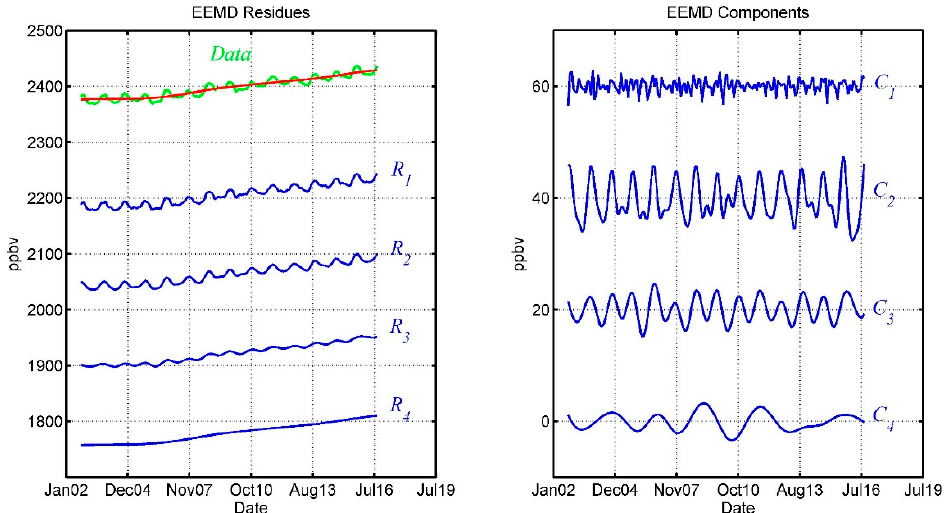
Figure 2. Ensemble Empirical Mode Decomposition (EEMD) decomposition of the AIRS CH 4 over the Tropics region. The left panel shows the original data (green line) and successive remainders ( R j ) after an additional EEMD component ( C j ) being extracted, i.e., R j = R j − 1 − C j for j > 1. The red line is the EEMD trend. In the right panel, each line represents an EEMD component ( C j ) from high frequency to low frequency.